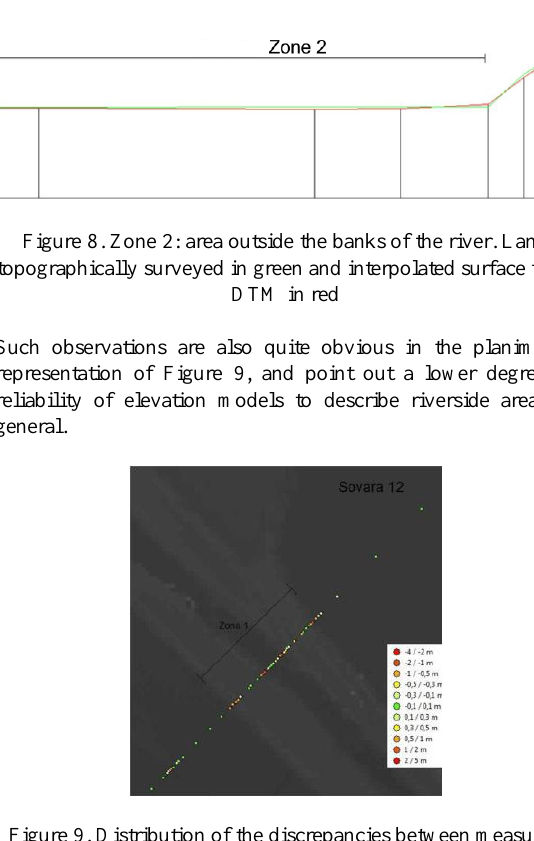
Figure 7. Zone 1: area between the foot of the embankment slopes. Topographic survey in green and interpolated surface from DTM in red